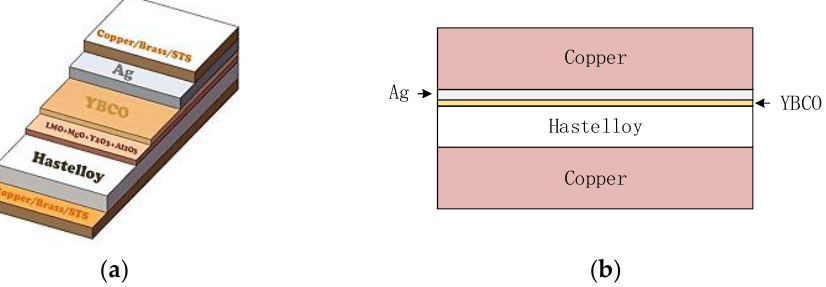
Figure 4. The structure of superconducting tape. ( a ) The structure of the 2G HTS tape; ( b ) 2D full model in Comsol Multiphysics. Here, the buffer layer is omitted because its thin width and poor conductivity affect the characteristics of the tape.